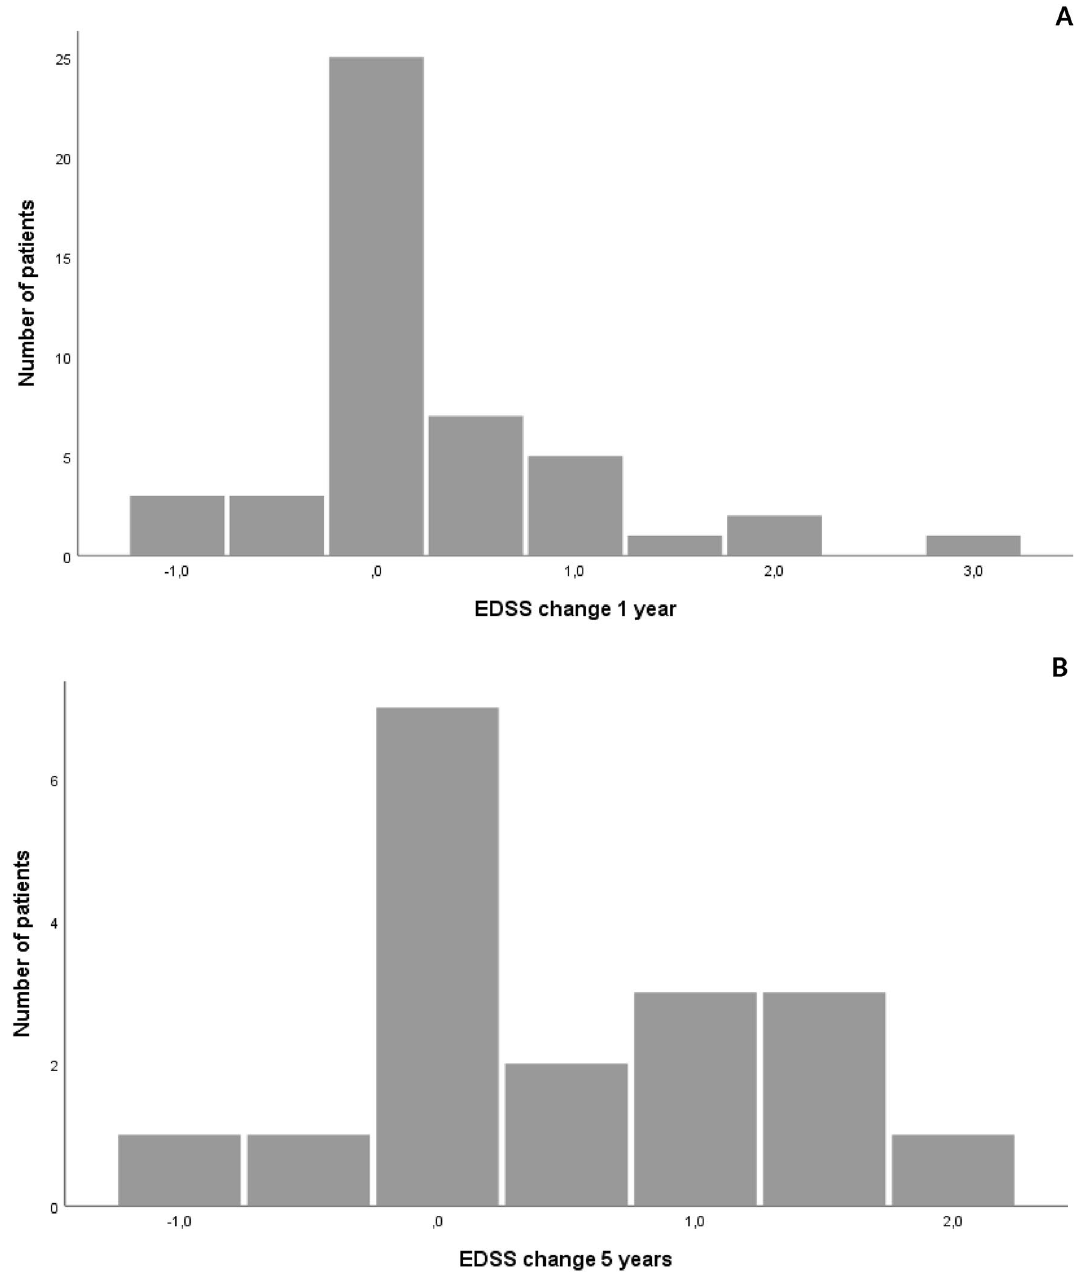
Figure 5. Change of EDSS score after NTZ discontinuation. Change of EDSS score within one ( A , 47 patients) and 5 years ( B , 18 patients) from time of NTZ discontinuation. Only patients with a NTZ treatment duration ≥ 2 years were